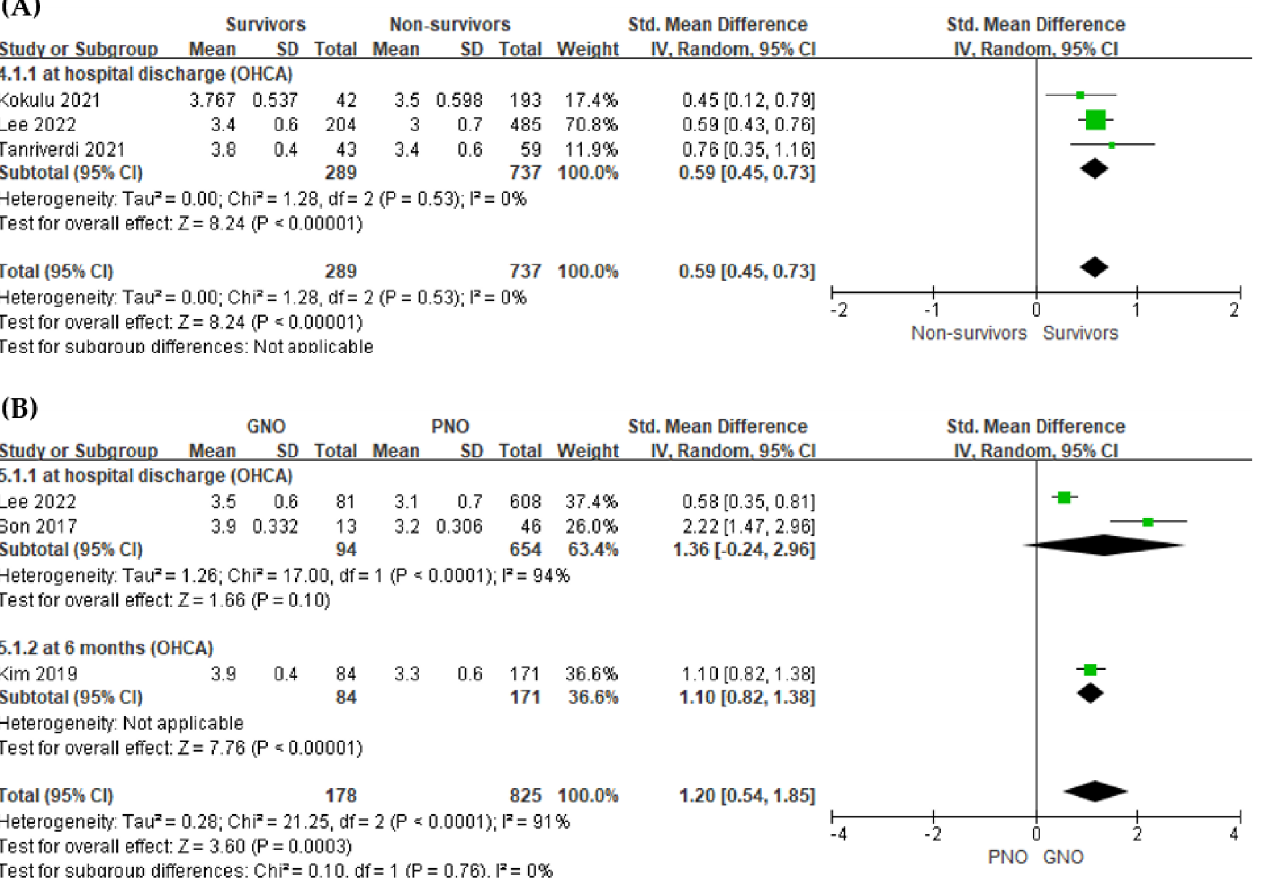
Figure 3. Forest plot of the association between early phase serum albumin level and outcomes of out-of-hospital cardiac arrest patients. ( A ) in-hospital mortality ( B ) neurologic outcome.